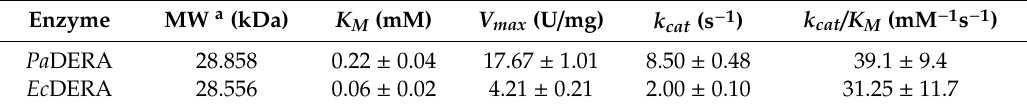
Table 1. Michaelis–Menten kinetic parameters of Pa DERA and Ec DERA *.